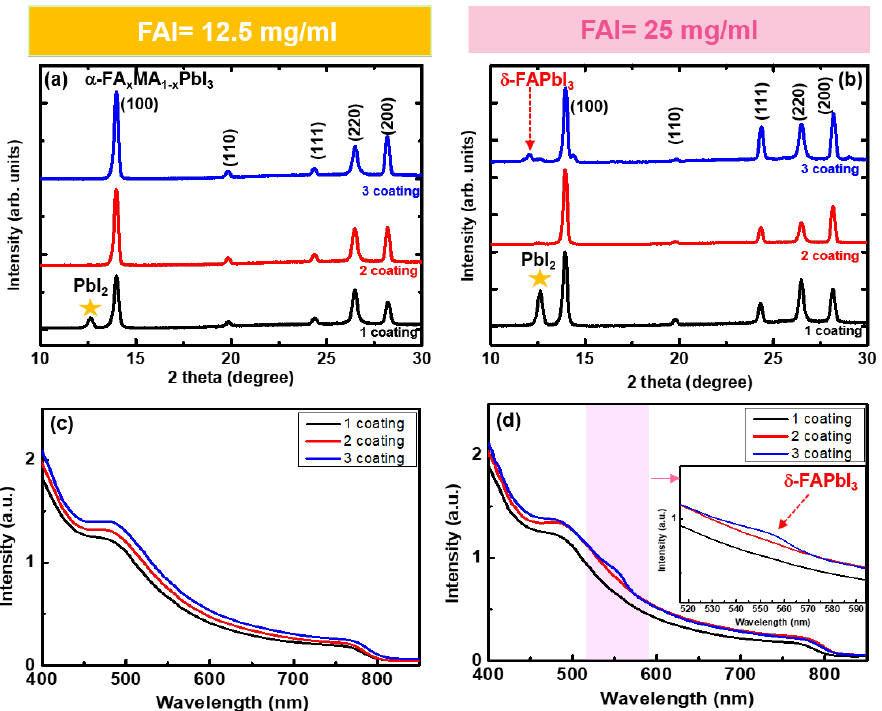
Figure 3. ( a , b ) XRD patterns of FA x MA 1 − x PbI 3 from 1 to 3 coatings with FAI = 12.5 and 25 mg/mL, respectively. Absorption spectra with ( c ) 12.5 and ( d ) 25 mg/mL FAI. The inset shows enlarged absorption spectra.